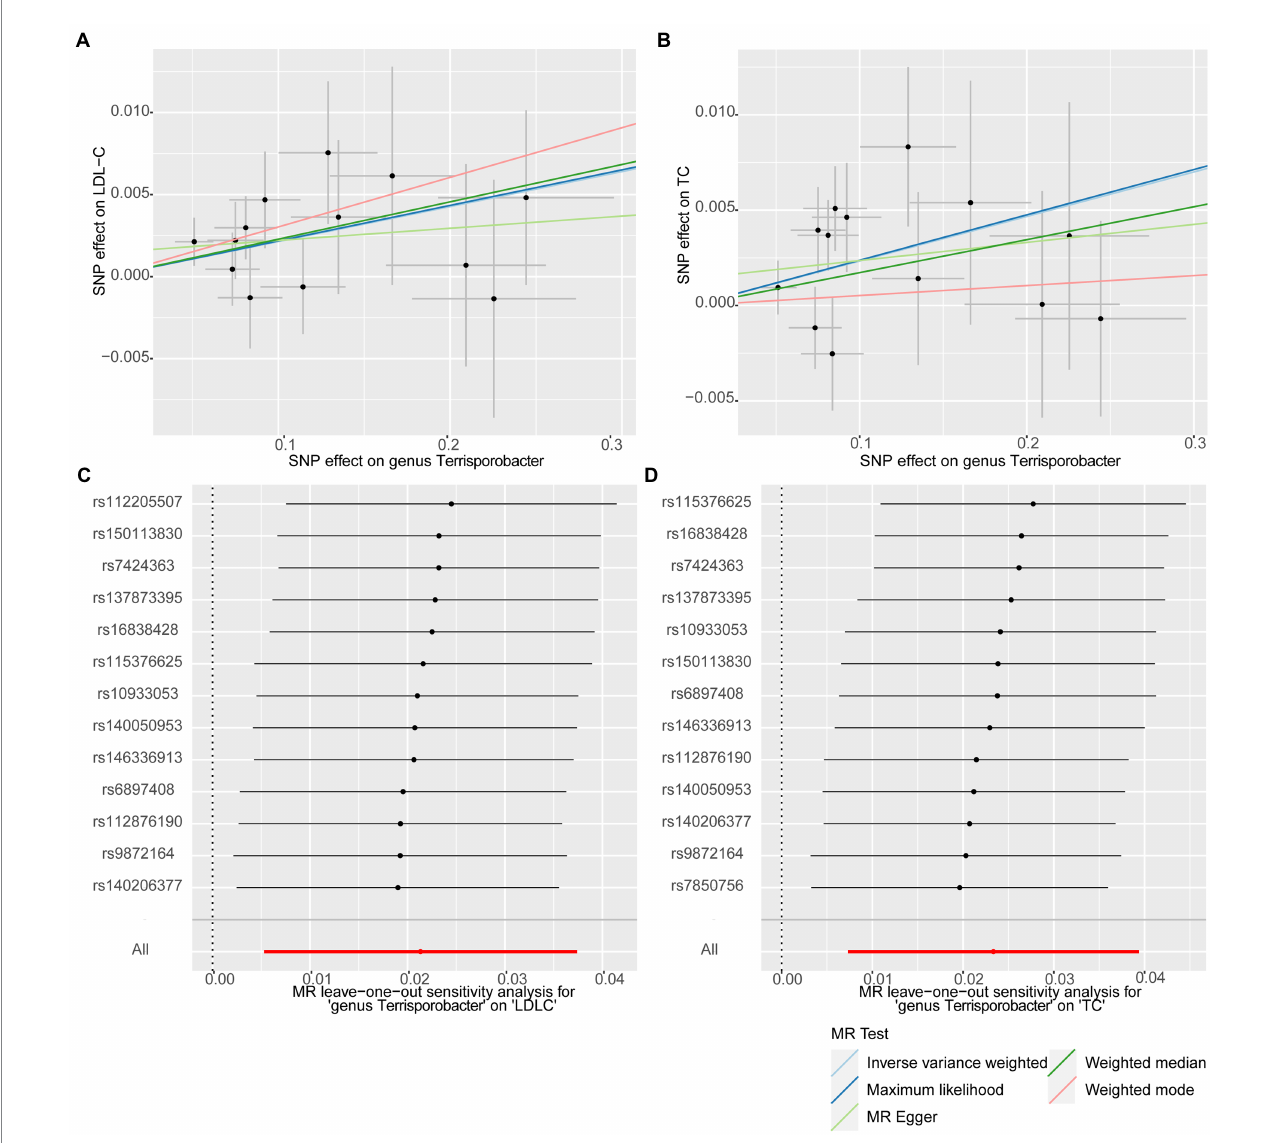
FIGURE 5 Plots of the significant results of the replication MR analysis. Scatter plots for the causal effects: (A) Terrisporobacter (genus)–LDL-C. (B) Terrisporobacter (genus)–TC. Forest plots of leave-one-out sensitivity analysis: (C) Terrisporobacter (genus)–LDL-C. (D) Oscillospira